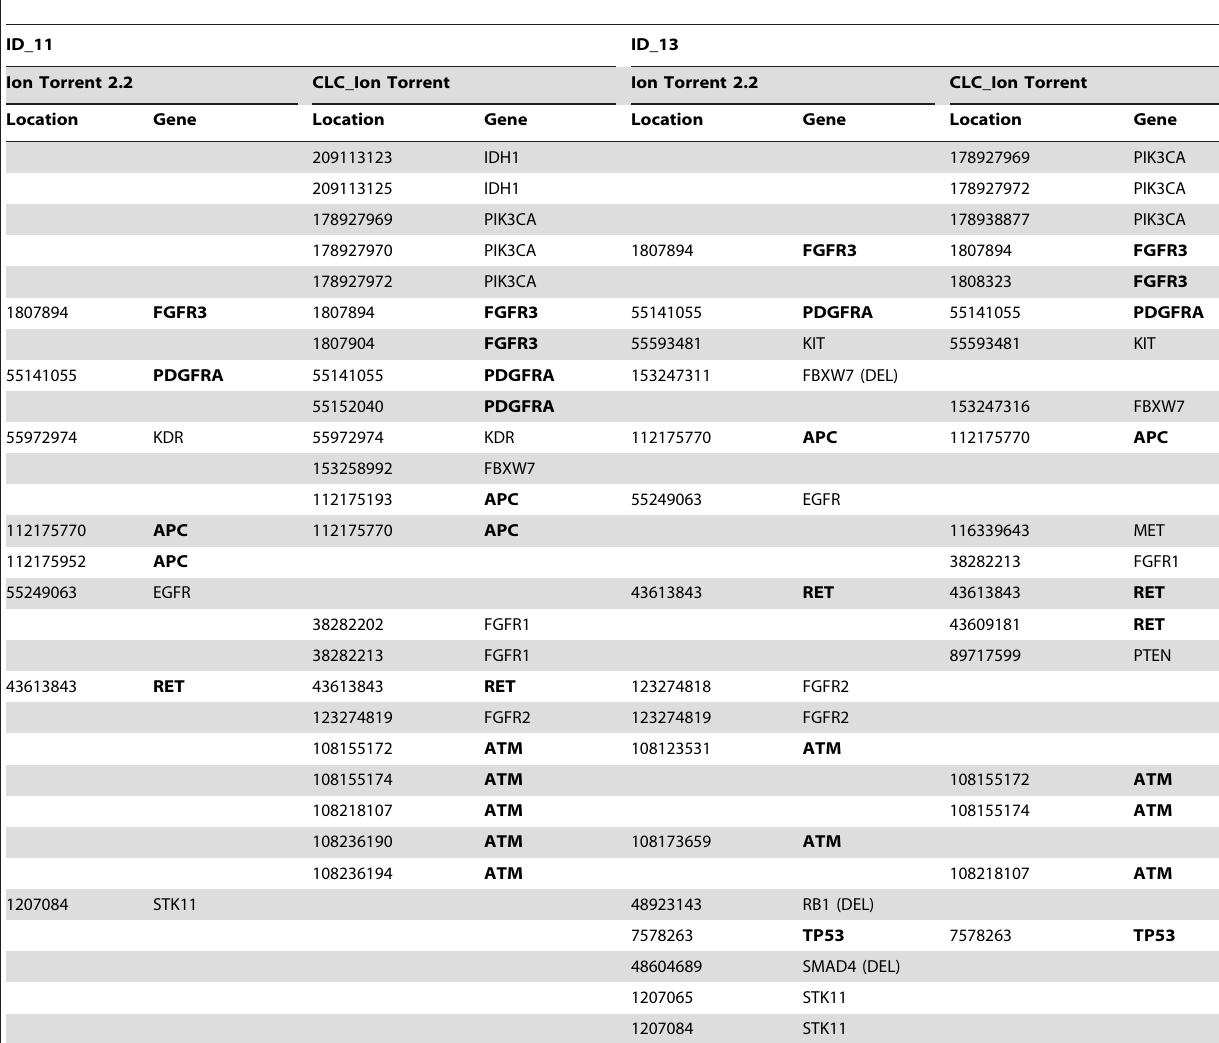
Table 4. NGS gene mutation detection using the Ion AmpliSeq Cancer Panel in colorectal carcinoma.